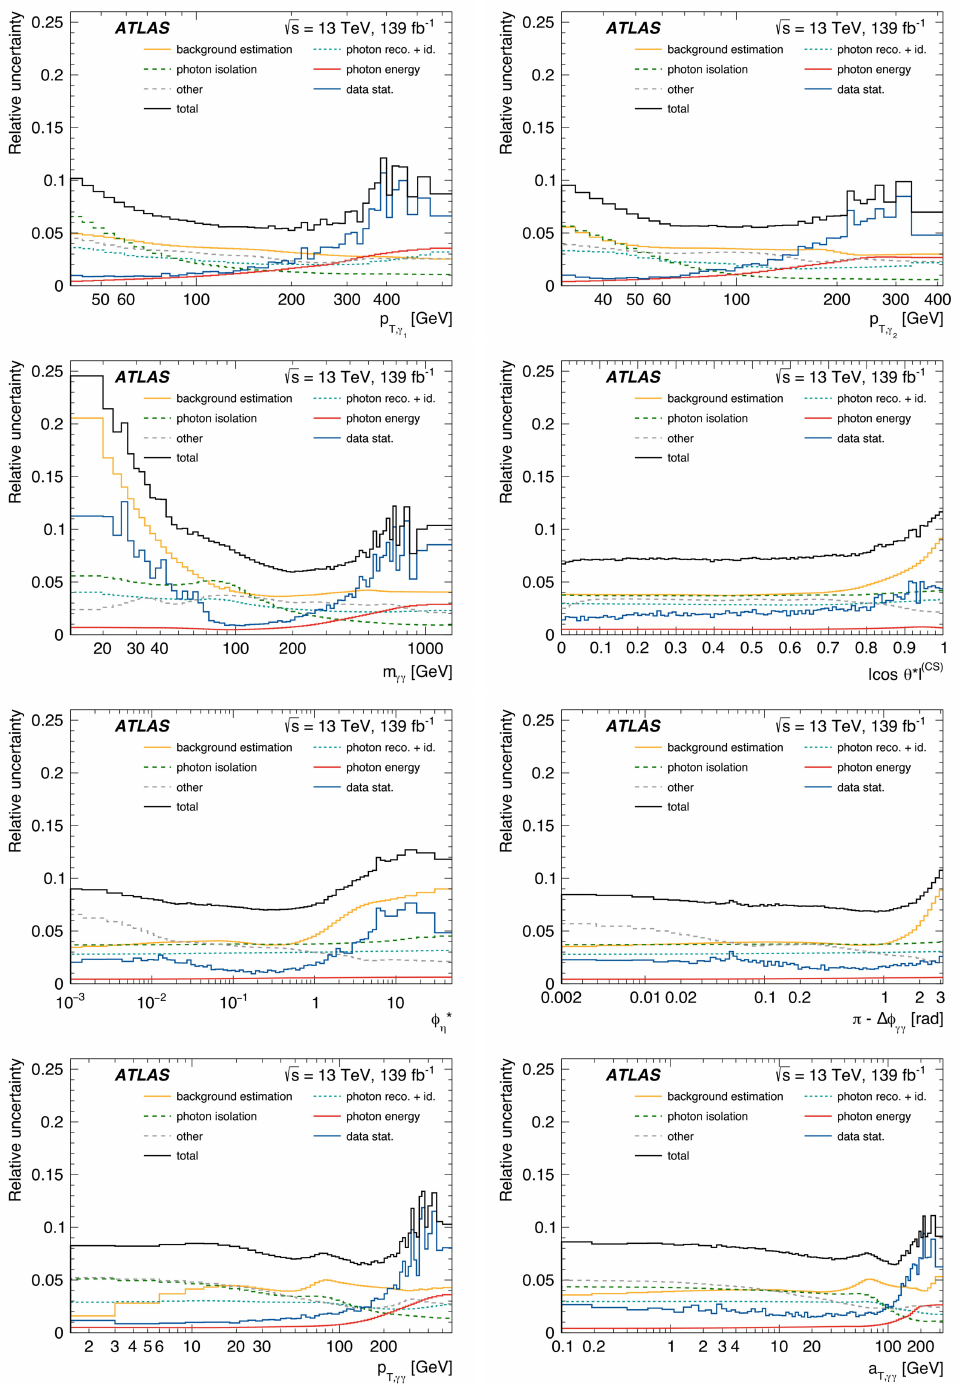
Figure 9. The relative uncertainties in the unfolded result associated with different sources are summarised. The uncertainty components and the total uncertainty are shown as a function of each of the